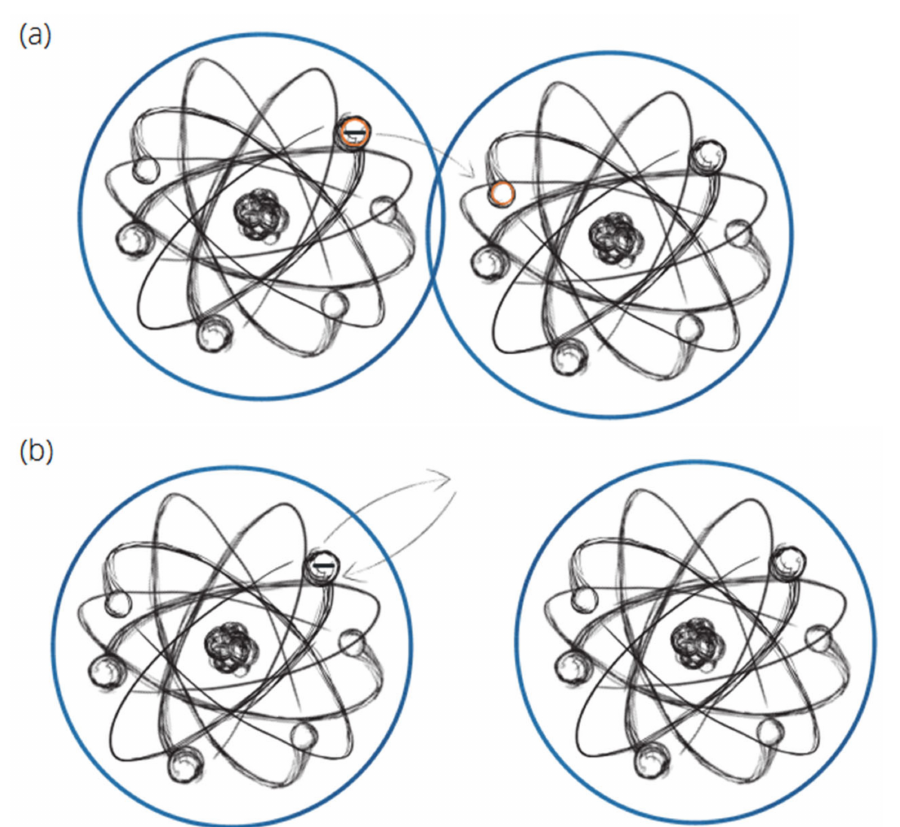
Figure 20. The transmission of an electrical charge in relation to the distance of the conductive elements: ( a ) conductive layers of the individual elements are intertwined, enabling transmission; ( b ) the conductive layers of the individual elements are not connected, disabling